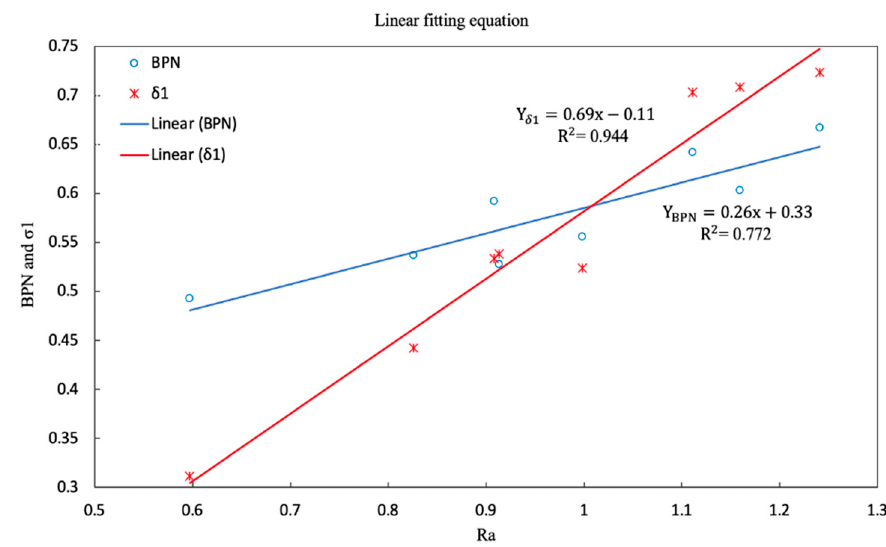
Figure 6. BPN and σ i with R a linear fitting equation.